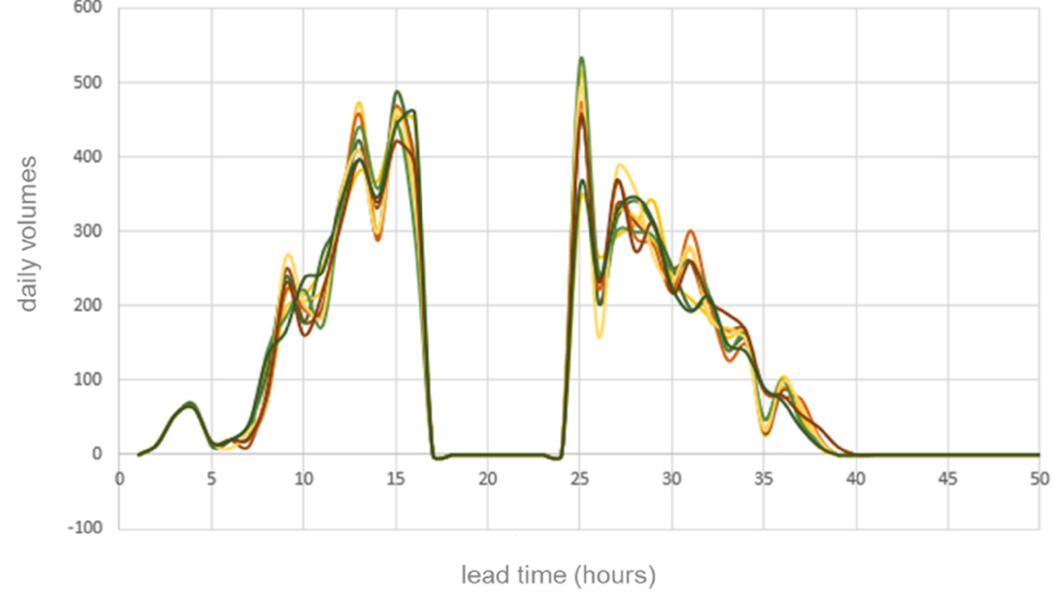
Figure 8. Distribution of the order lead times for different randomized simulation runs.